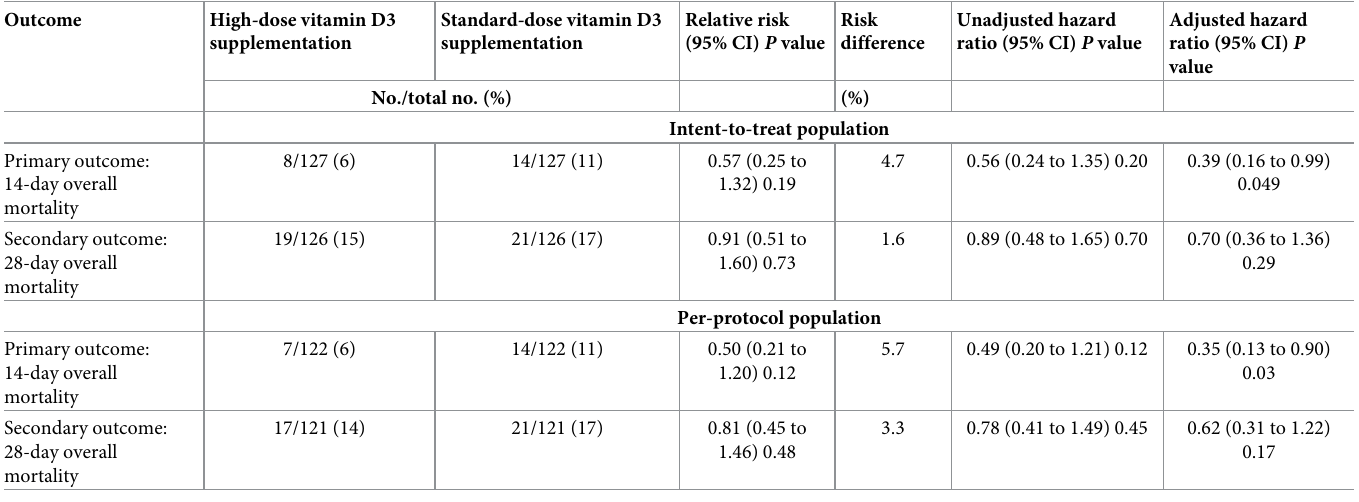
Table 2. Effect of allocation to high-dose or standard-dose vitamin D3 supplementation on the primary and secondary outcomes, in intention-to-treat and per-pro- tocol